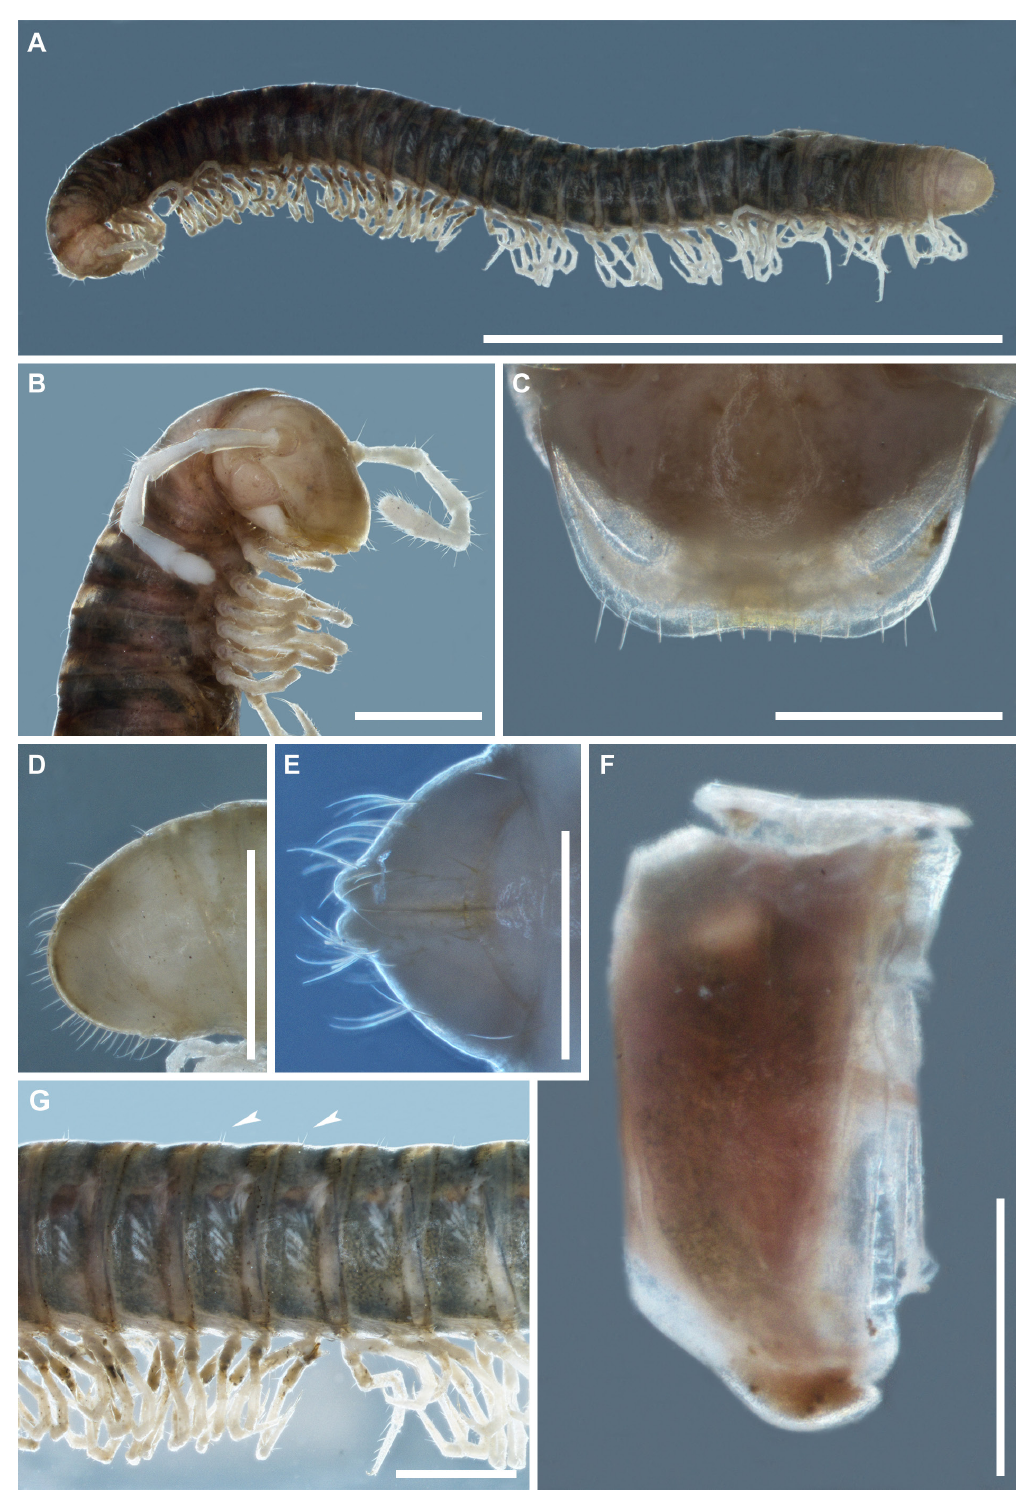
Fig. 8. Leucogeorgia longipes Verhoeff, 1930 (A–D, F–G: ♂♂ from Kotias Cave (IZISU); E: ♂ from Dolabistavi Cave (SMNG)). A . Habitus, lateral view. B . Anterior part of body, anterolateral view. C . Head, anterodorsal view. D . Telson, lateral view. E . Telson, ventral view. F . Body ring 7, lateral view. G . Midbody rings, lateral view. Arrows indicate metazonal setae. Scale bars: A = 5 mm; B, D, F = 1 mm; C, E, G = 0.5